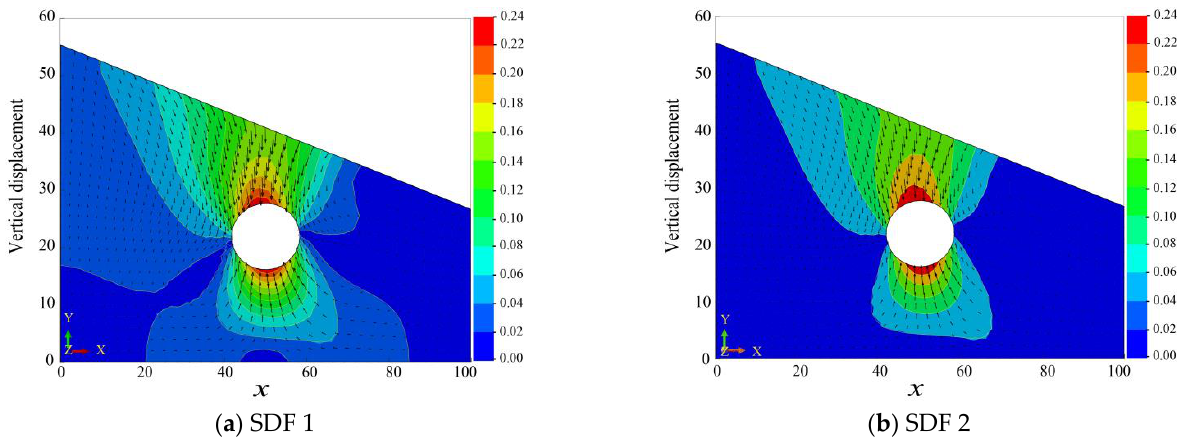
Figure 19. Tunnel deformation beneath an inclined plane.